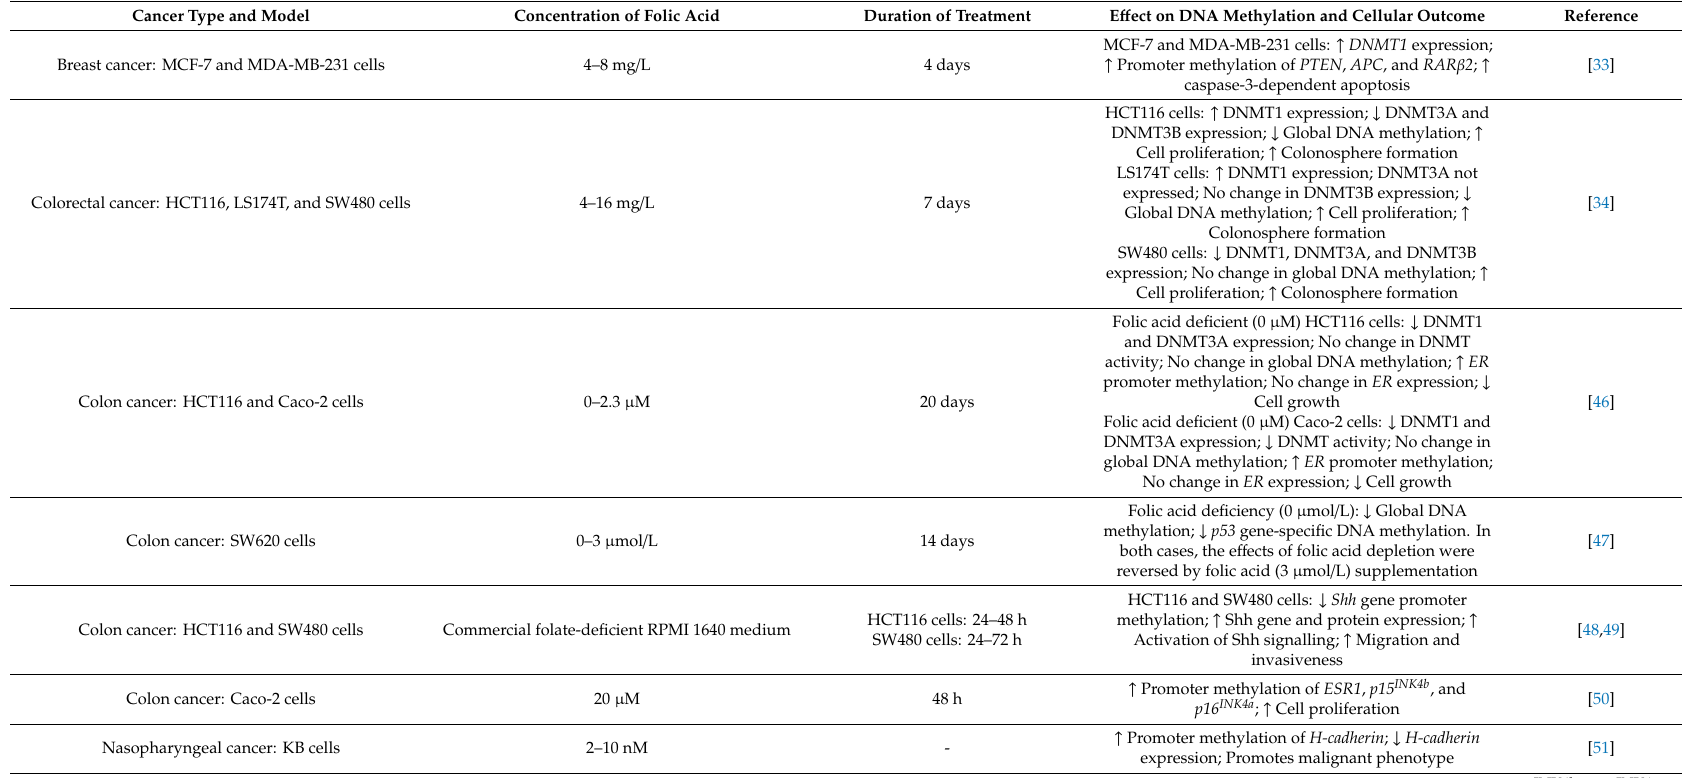
Table 1. The e ff ect of folic acid on global and gene promoter DNA methylation in various human cancer cell